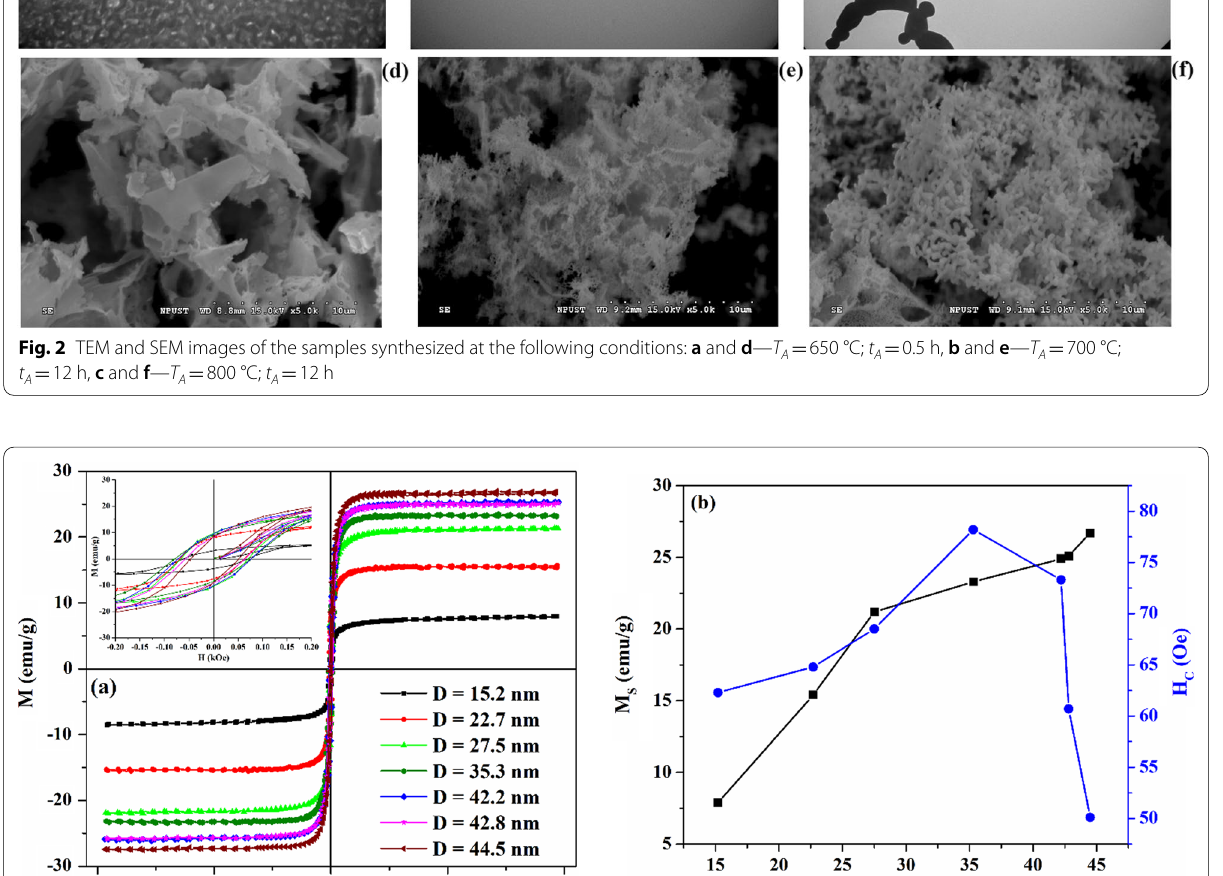
Fig. 3 a Magnetic hysteresis loops of the samples obtained at various annealing temperatures and annealing times; b dependence of saturation magnetization and coercivity on crystallite size. The inset shows the hysteresis loops on an enlarged